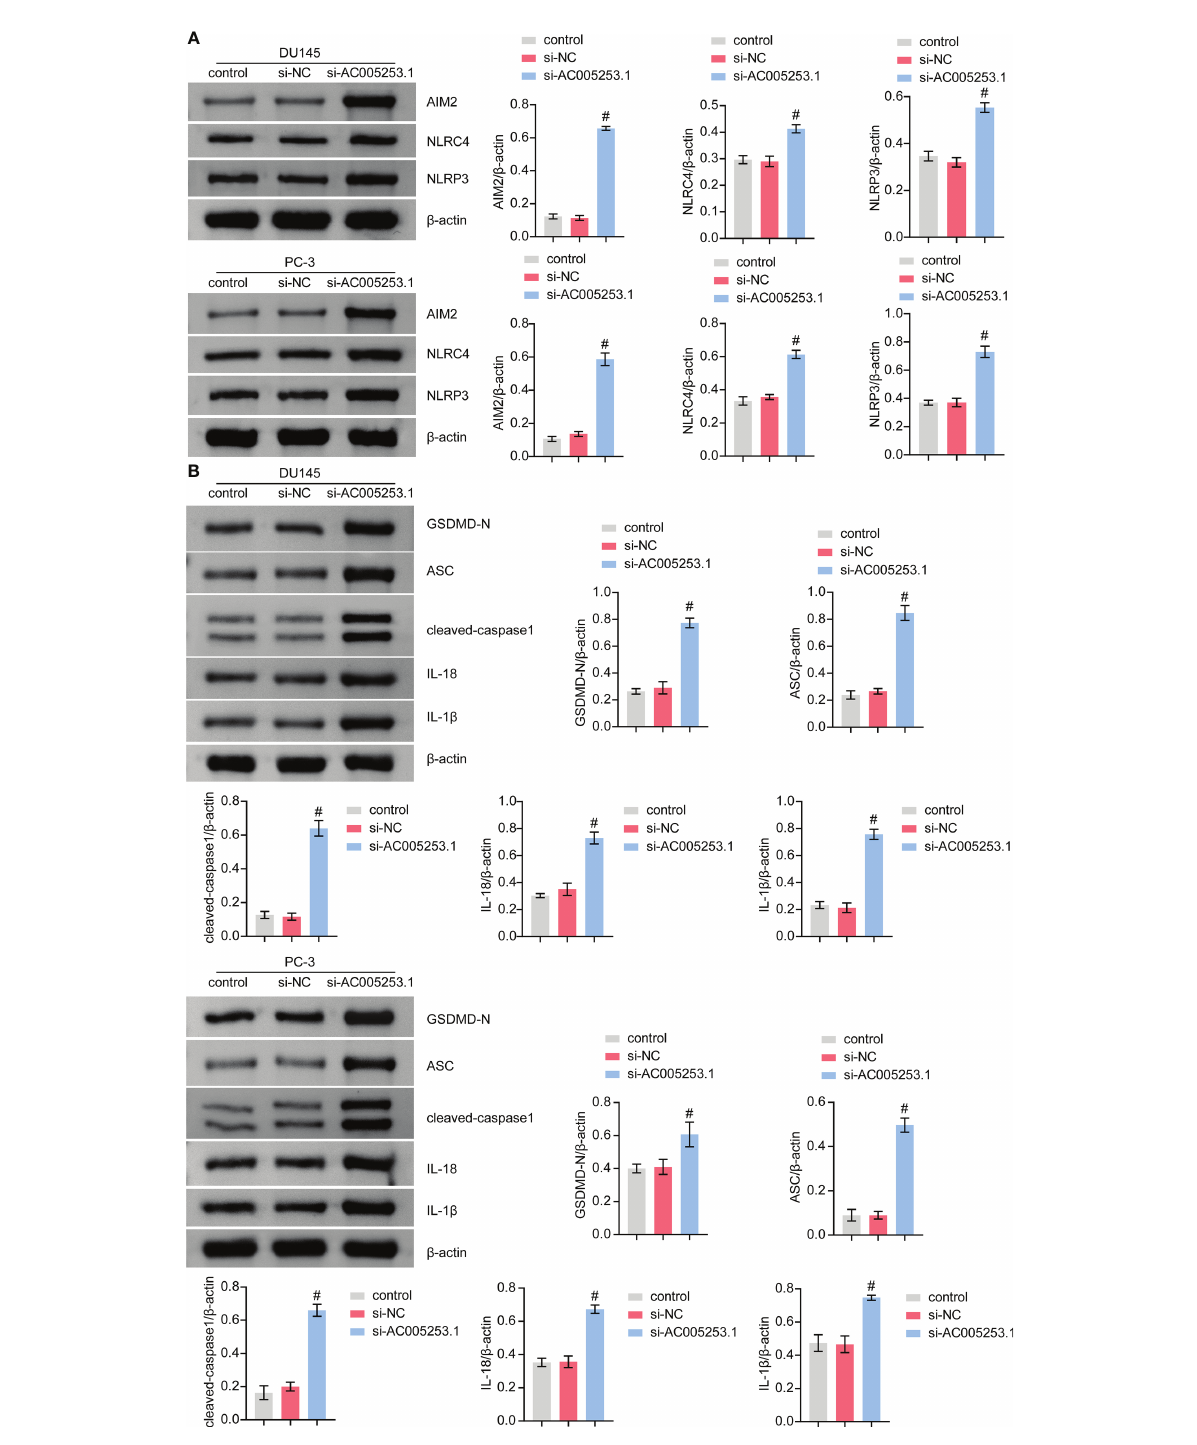
FIGURE 9 Silencing of AC005253.1 promoted pyroptosis of PCa cells. (A) AIM2, NLRC4, and NLRP3 levels were identi fi ed by Western blotting. (B) GSDMD- N, ASC, caspase-1, IL-18, and IL-1 b proteins were identi fi ed by Western blotting in PC-3 and DU145 cells. #p < 0.05, vs. si-NC group. PCa, prostate